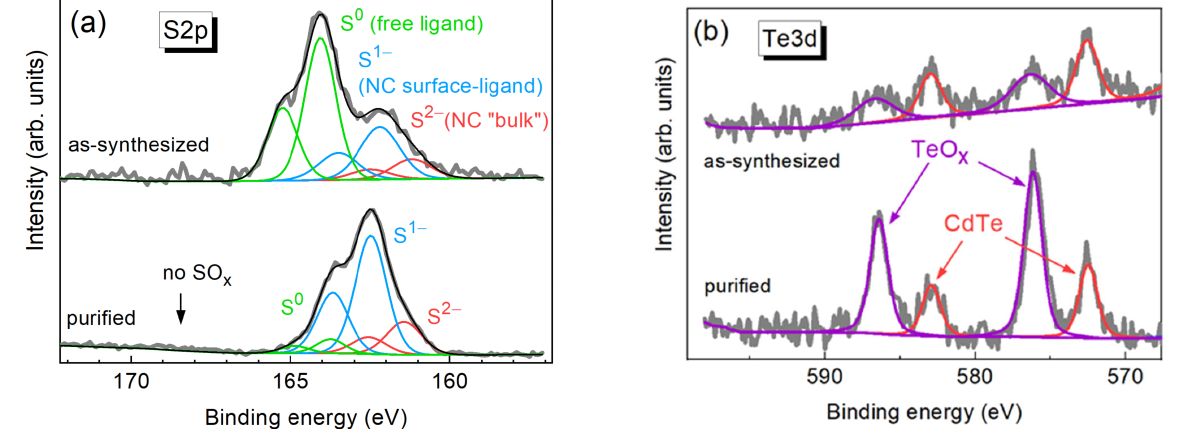
Figure 2. High ‐ resolution XPS spectra of CdTe ‐ TGA NCs in the range of S2p ( a ) and Te3d ( b ) core levels for the as ‐ synthesized NCs (upper spectra) and after purification from excess ligands (lower core levels for the as-synthesized NCs (upper spectra) and after purification from excess ligands spectra). (lower